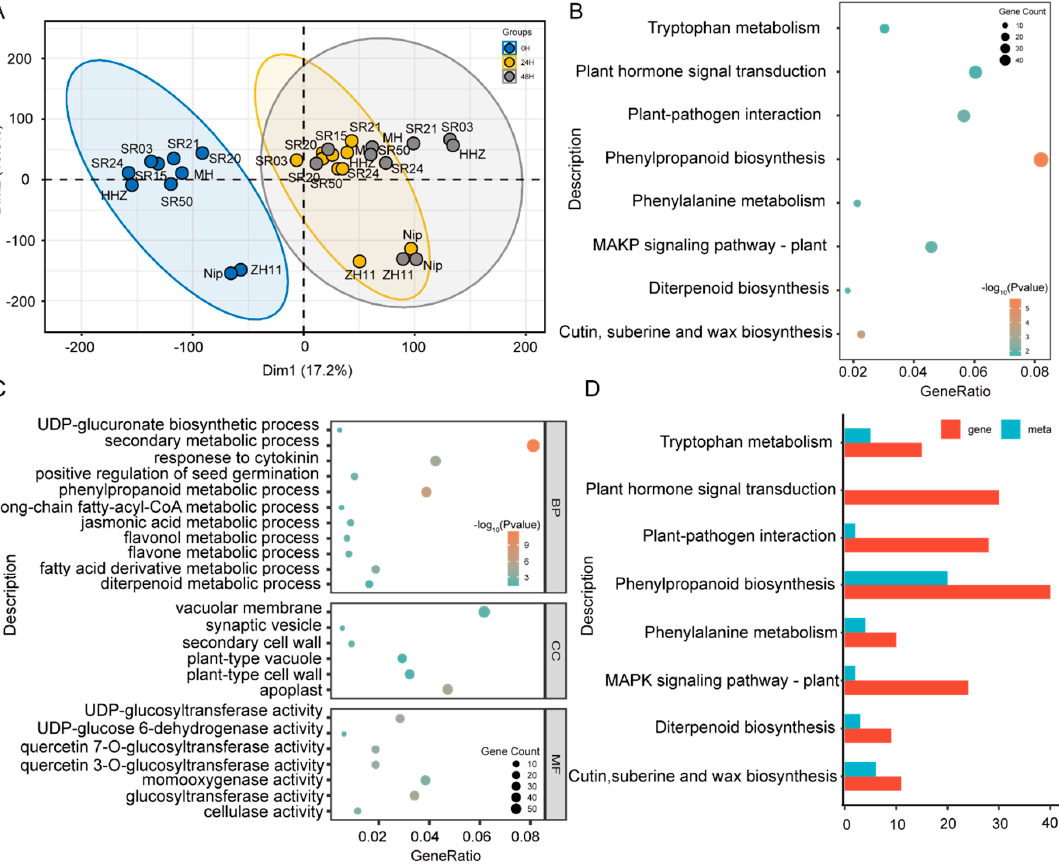
Figure 3. Construction of a metabolite–gene regulatory network in cultivar rice and landrace seeds during germination. ( A ) A PCA analysis based on the transcriptome in the seeds of landraces and cultivated rice during germination. ( B ) KEGG analysis of DEGs in the seeds of landraces and cultivated rice during germination. Y -axis represents KEGG pathways, and X -axis indicates the gene ratio. ( C ) GO enrichment analysis of DEGs in the seeds of landraces and cultivated rice during germination. MF, molecular function; BP, biological process; CC, cellular component. ( D ) KEGG analysis of DAMs and DEGs in the seeds of landraces and cultivated rice during germination.